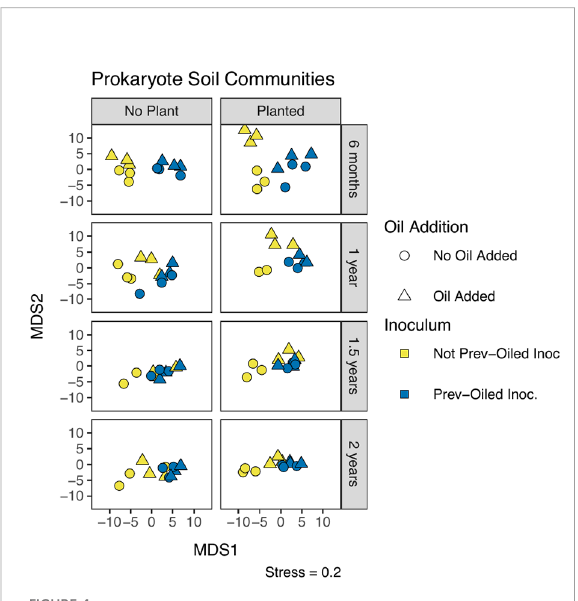
FIGURE 4 NMDS of prokaryote community composition in soil, measured by Aitchison distance. Each point represents a single replicate at a time point. Sampling points correspond to individual panels, chronologically from top to bottom. The two columns of panels represent whether or not a plant was in the mesocosm. The oil addition treatment is represented by shape and the inoculum treatment by